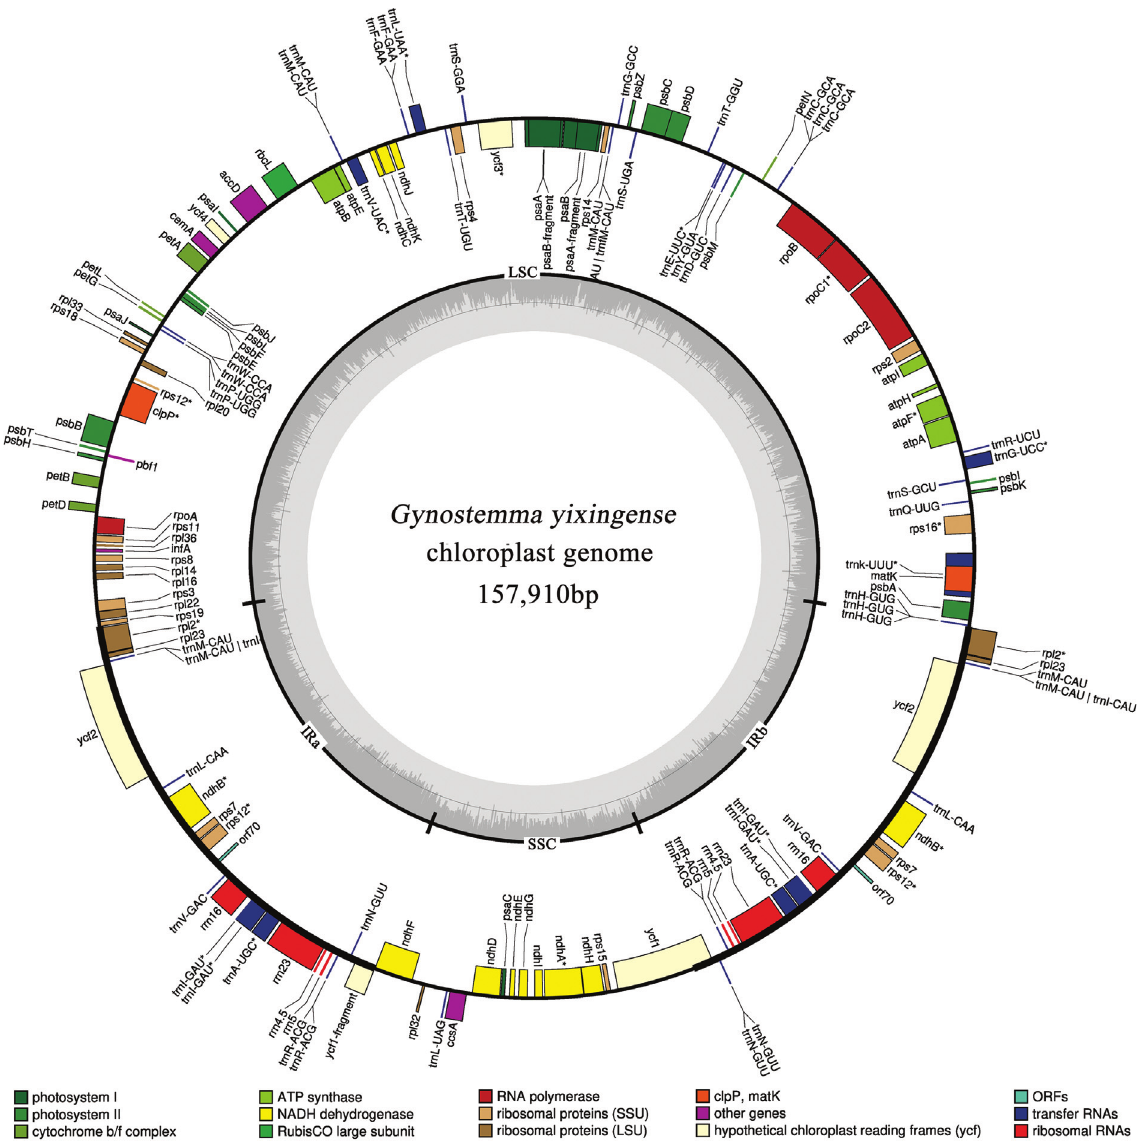
Figure 1 - Chloroplast genome map of Gynostemma yixingense . Genes drawn inside the circle are transcribed clockwise, genes outside are transcribed counterclockwise. Genes are color coded by their function in the legend. The area in darker gray and lighter gray in the inner circle indicates GC content and AT content,